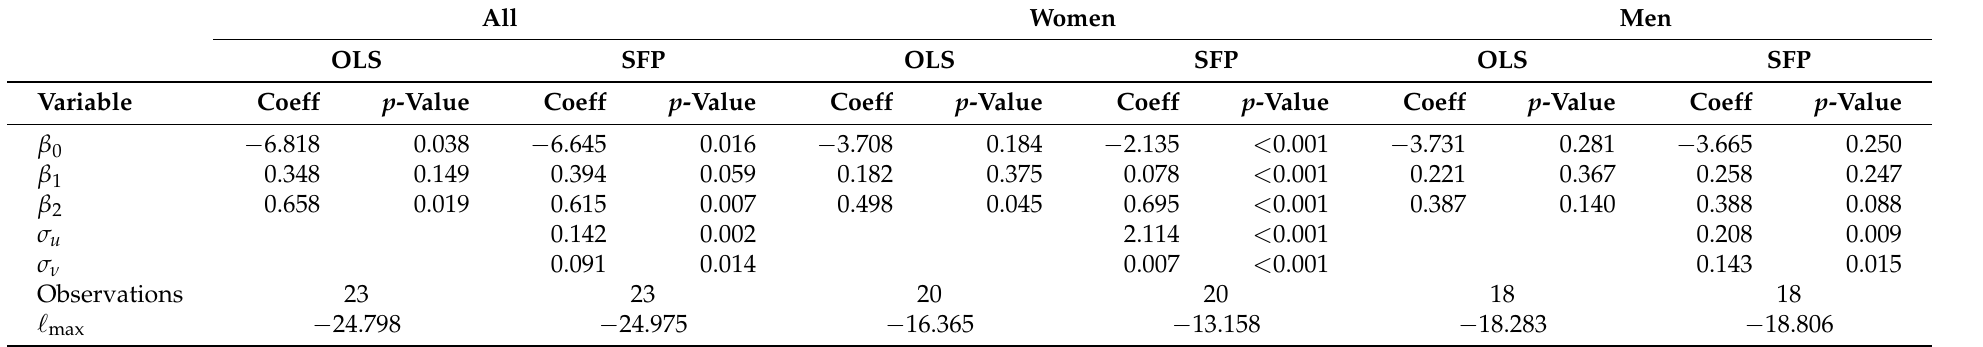
Table 4. Estimation of the model considering the different activities in the period 2005–2016.